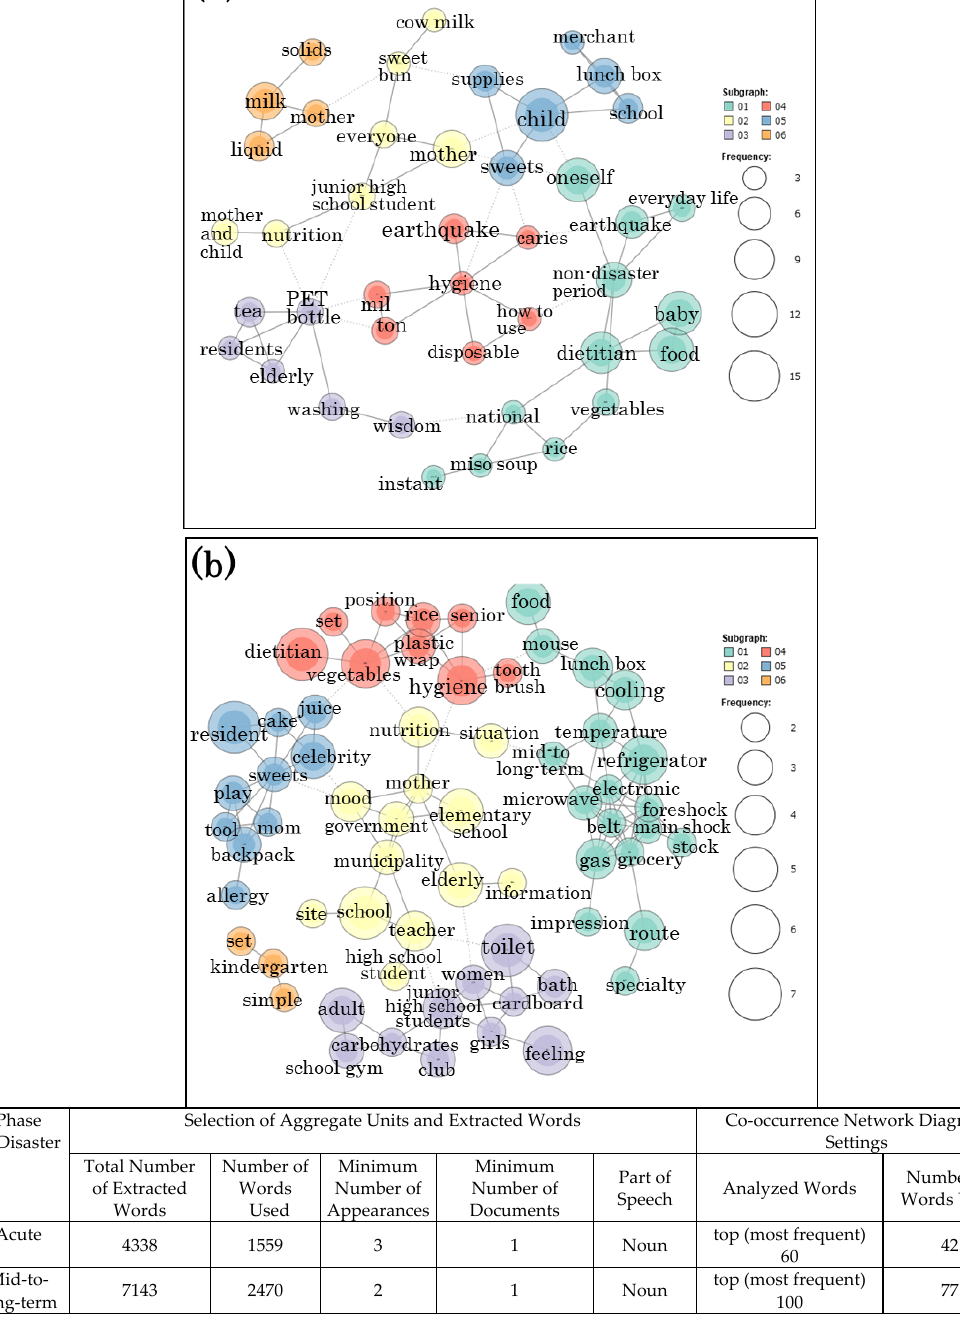
Figure 1. Co-occurrence network diagrams of Group 1 (severely damaged area) created using quantitative text analysis: Kumamoto earthquake. ( a ) acute phase; ( b ) mid-to-long-term phase.